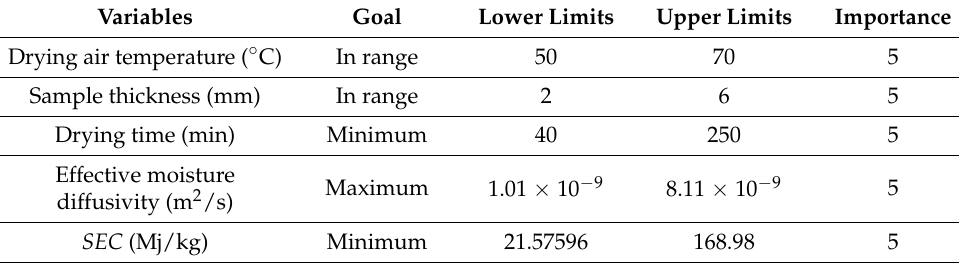
Table 1. Boundary conditions and the independent and dependent